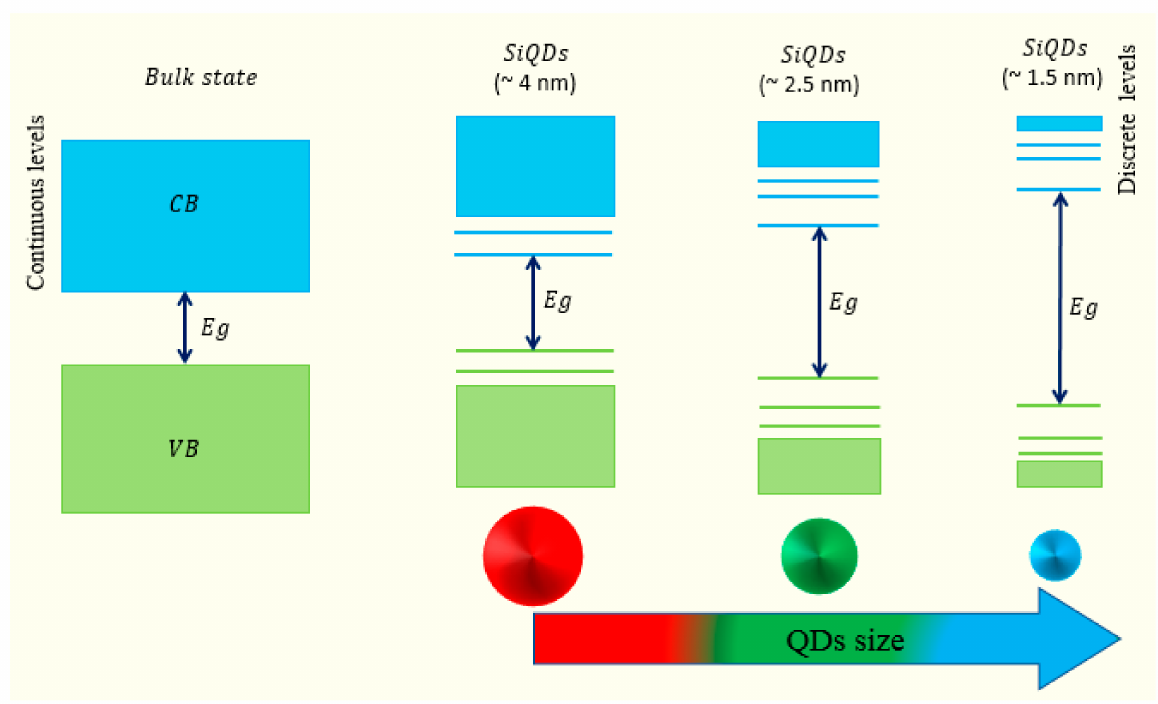
Figure 1. Schematic depiction of how the change from the bulk to the QDs impact the CB, VB levels, and Eg in